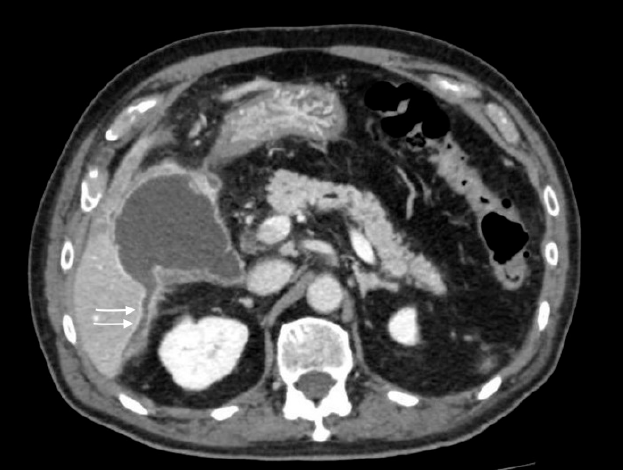
Figure 5. Gallbladder perforation: discontinuity of the gallbladder wall with fluid collection extended posteriorly to the right hepatic lobe